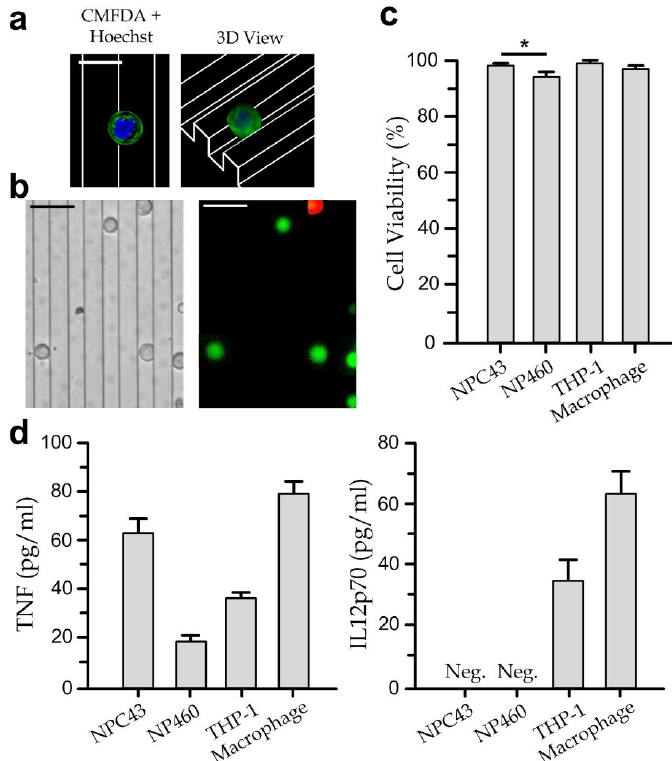
Figure 3. ( a ) Top view ( left panel) and three-dimensional view ( right panel) of the reconstructed confocal microscopy images of a NPC43 cell culture on a micro-grating array. Scale bar: 20 μm. ( b ) Brightfield ( left ) and live/dead-stained ( right ) images of NPC43 cultured on micro-gratings for 8 h. Scale bar: 30 μm. ( c ) Viability of NPC43, NP460, THP-1 and THP-1-derived macrophages in the culturing chamber for 8 h. Asterisk represents a p -value of <0.05 calculated by Student’s t -test. ( d ) Cytokine secretions of mono cultured NPC43/NP460 cells and immune cells on micro-gratings after 8 h of culture. Error bars represent the standard errors.